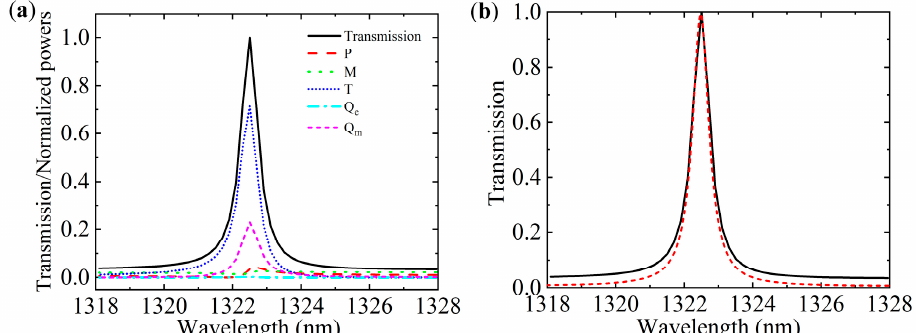
Figure 5. ( a ) Normalized scattered power of the five major multipoles and the reconstructed transmission of the all-dielectric metasurface. The five major multipoles are electric dipole ( P ), magnetic dipole ( M ), toroidal dipole ( T ), electric quadrupole ( Q e ), and magnetic quadrupole ( Q m ), respectively. ( b ) Calculated transmission (red dashed line) and reconstructed transmission (black solid line).